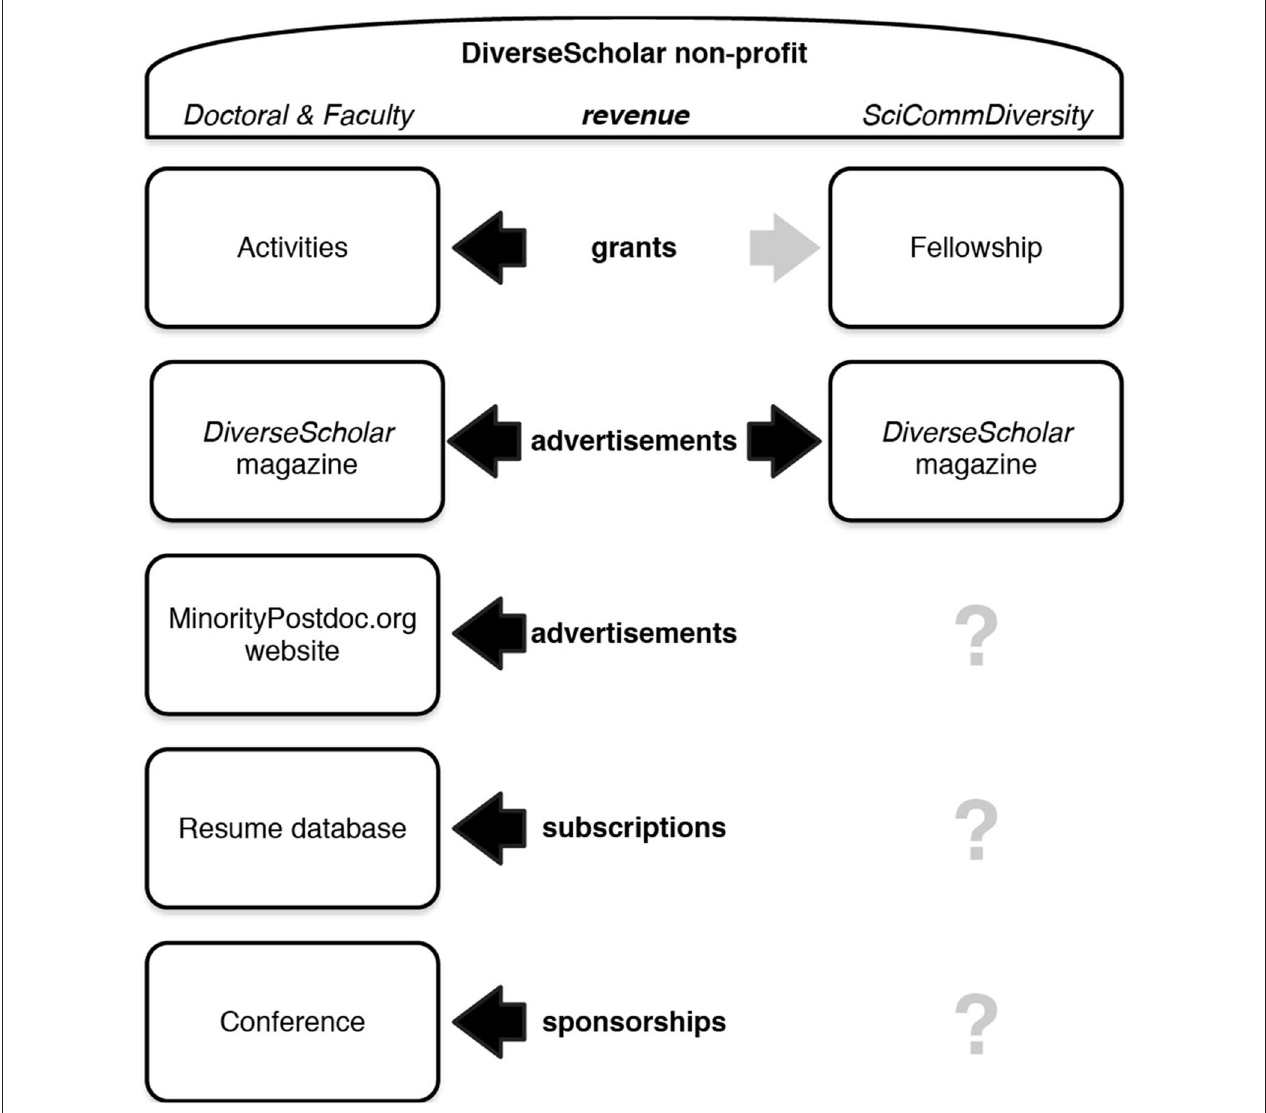
FIGURE 1 | Schematic of the relationship between the DiverseScholar non-profit and its projects. The MinorityPostdoc STEM doctoral activities (left column) are complementary to the SciCommDiversity Fellowship (right column) but the former has established revenue streams that are currently subsidizing the fellowship since the Idea grant ended after the first 2